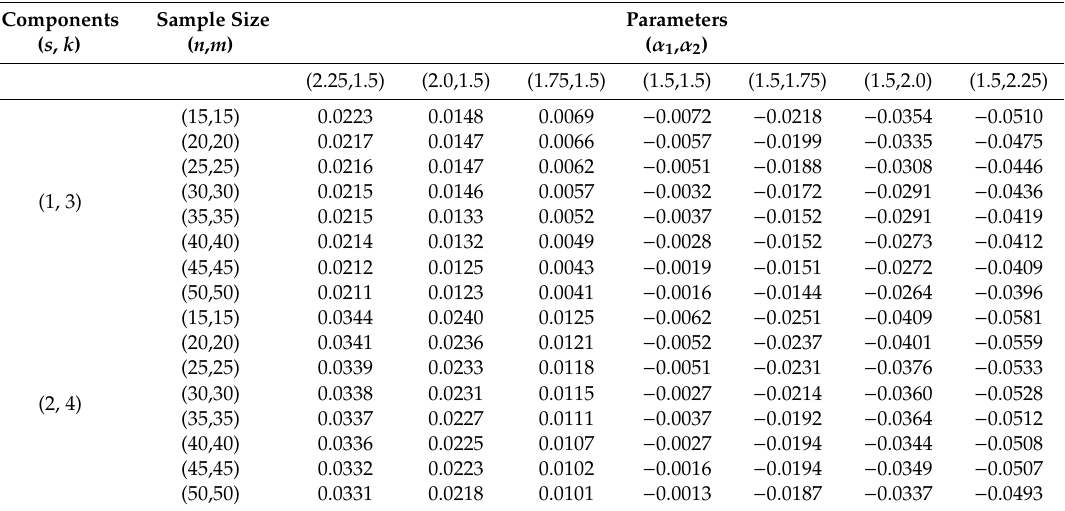
Table 1. Bias of the simulated estimates of reliability R s , k .